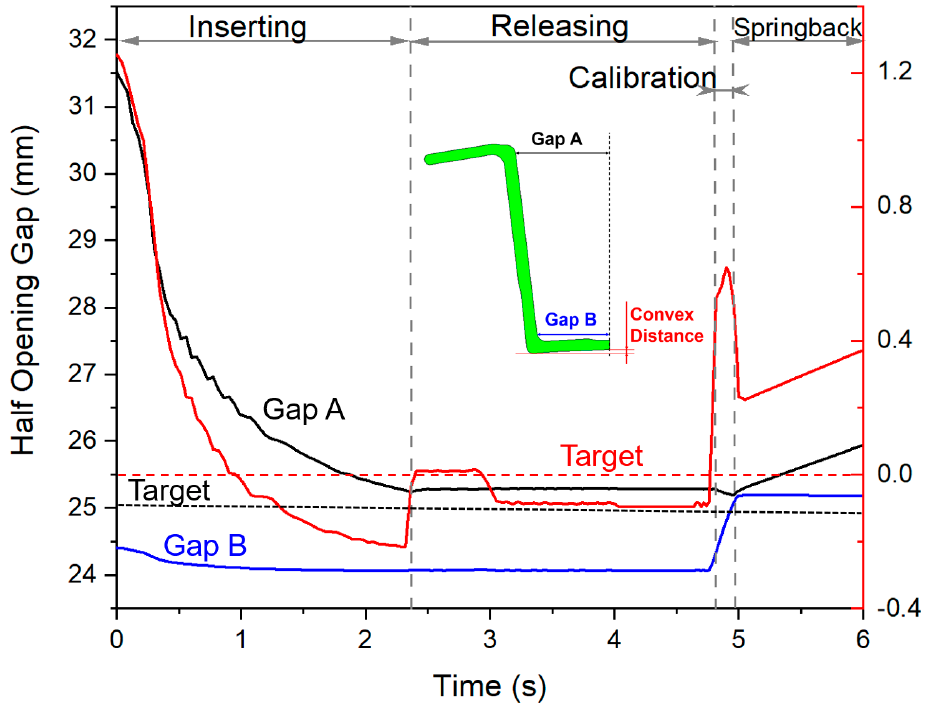
Figure 11. Dimensional evolution during the TSLB process in terms of gap A and B and convex distance.